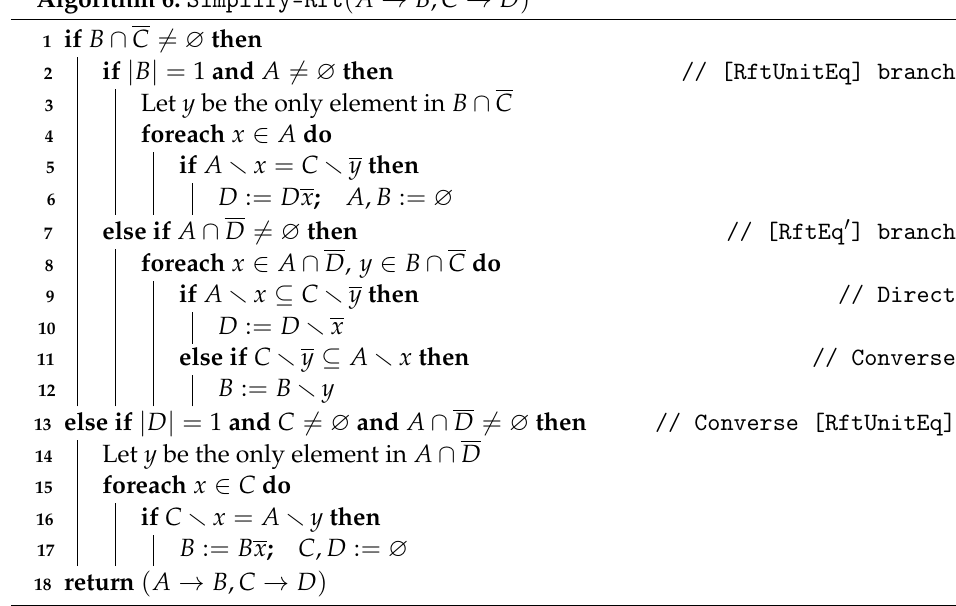
Algorithm 6: Simplify-Rft ( A